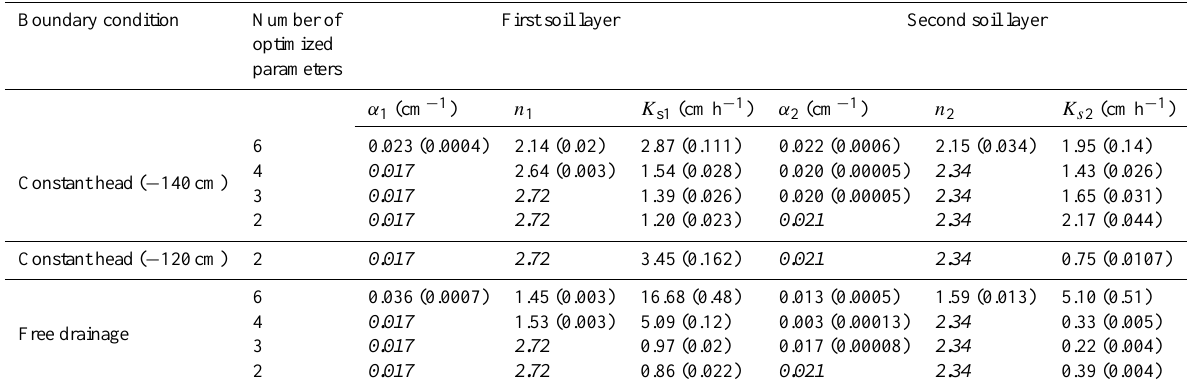
Table 2. Optimized values of hydraulic parameters for the optimization scenarios yielding uncorrelated parameters (except for reference scenario with six optimized parameters). Values indicated in italic are values fixed to the measured values close to the sensor location. Numbers in parentheses represent the standard errors of optimized